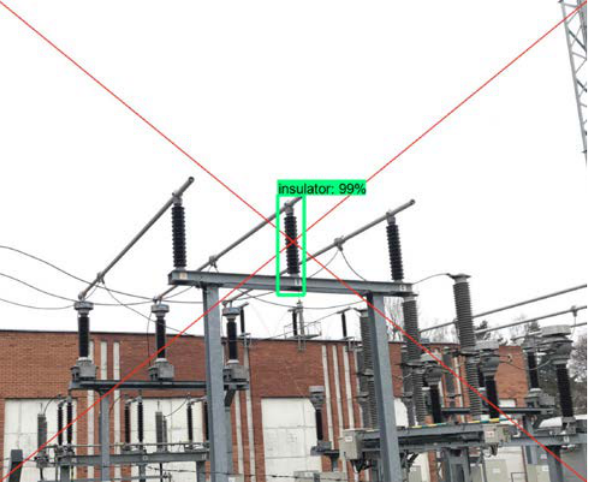
Figure 14. The final output image of the proposed discharge detection system, showing the suspi- cious element in the center of the image. Deep learning methods are used to determine the origin of the